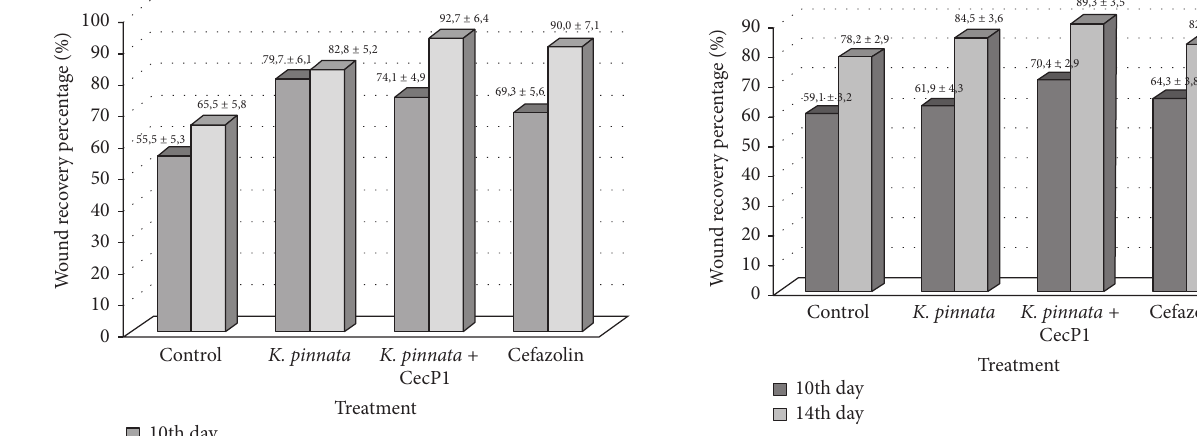
Figure 5: Testing healing of the wounds infected with combination of S. aureus and P. aeruginosa. Wound recovery percentage at 10th and 14th days after beginning of curing (M ± Std . Err . ) is